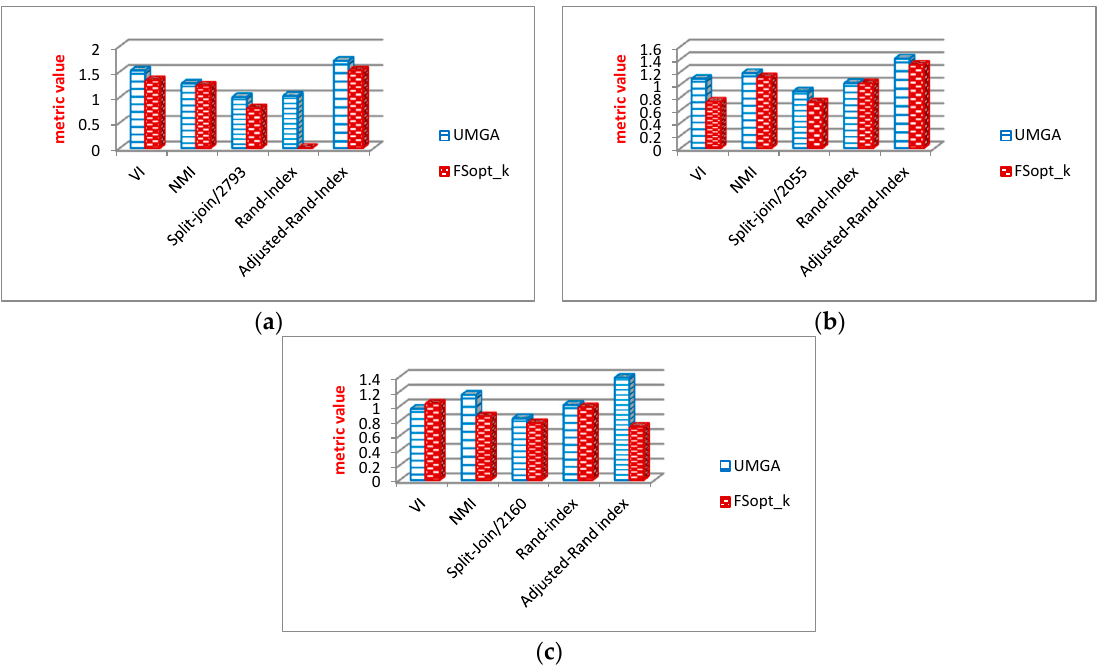
Figure 15. Evaluated values of community structure metrics on power grid for ( a ): ℒ = 0.05 , ( b ): ℒ = 0.1 , and ( c ): ℒ = 0.2 .